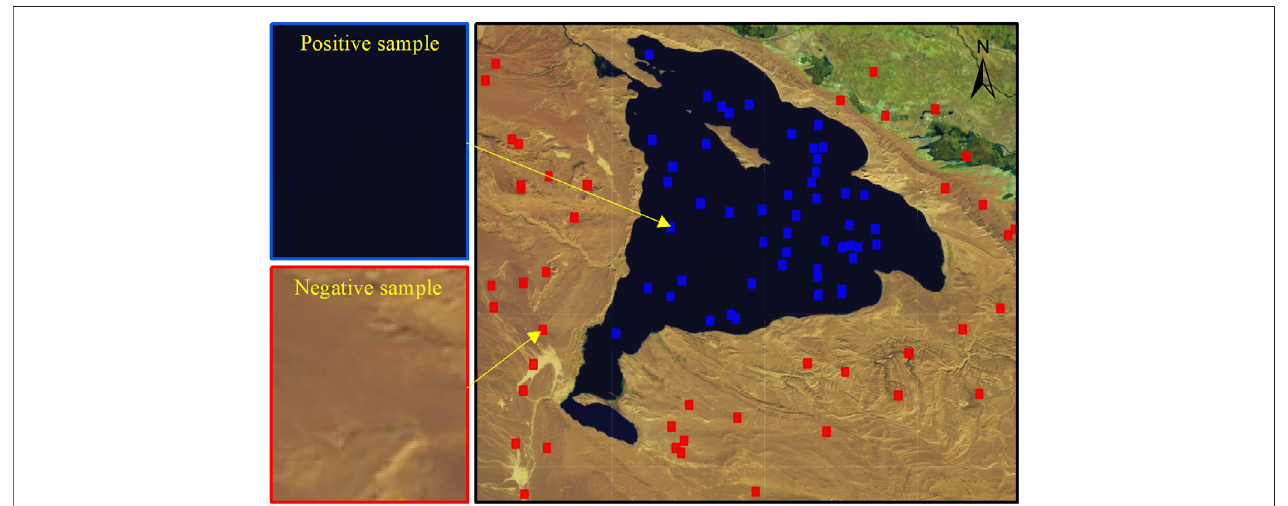
FIGURE 3 | Schematic diagram of SMV training sample